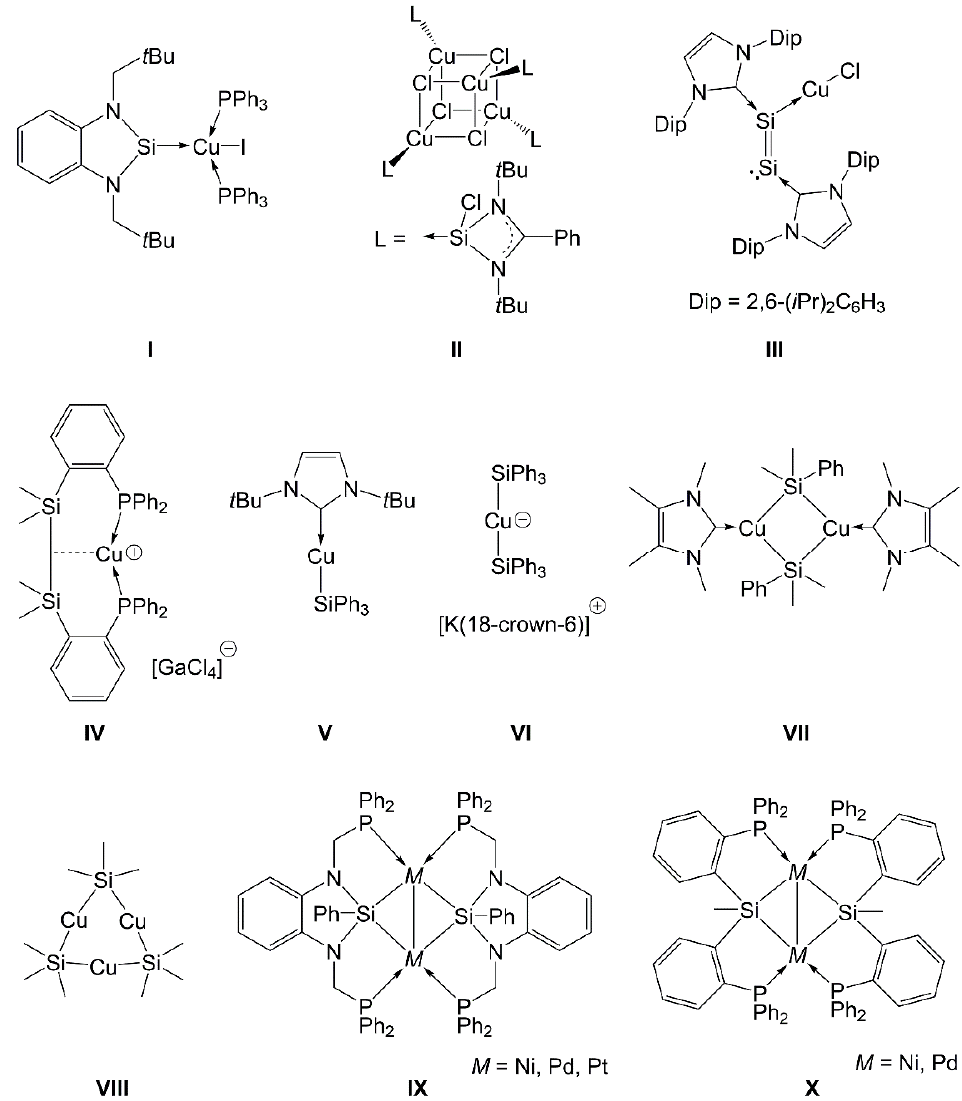
Figure 1. Selected examples of Si-Cu ( I – VIII ) and other Si-TM compounds ( IX , X ). For reasons of clarity of presentation, formal lone pair donation by L-type ligands (such as phosphanes, carbenes and silylenes) is indicated by a dative bond arrow, whereas X-type bonds (for example of silyl groups, regardless of two- or multi-center bonding thereof) are indicated by a regular bond dash.